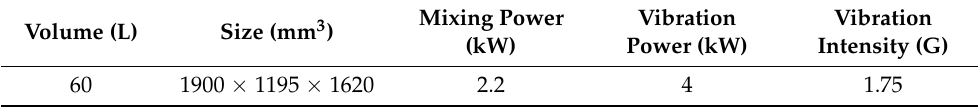
Table 4. Main performance parameters of vibration